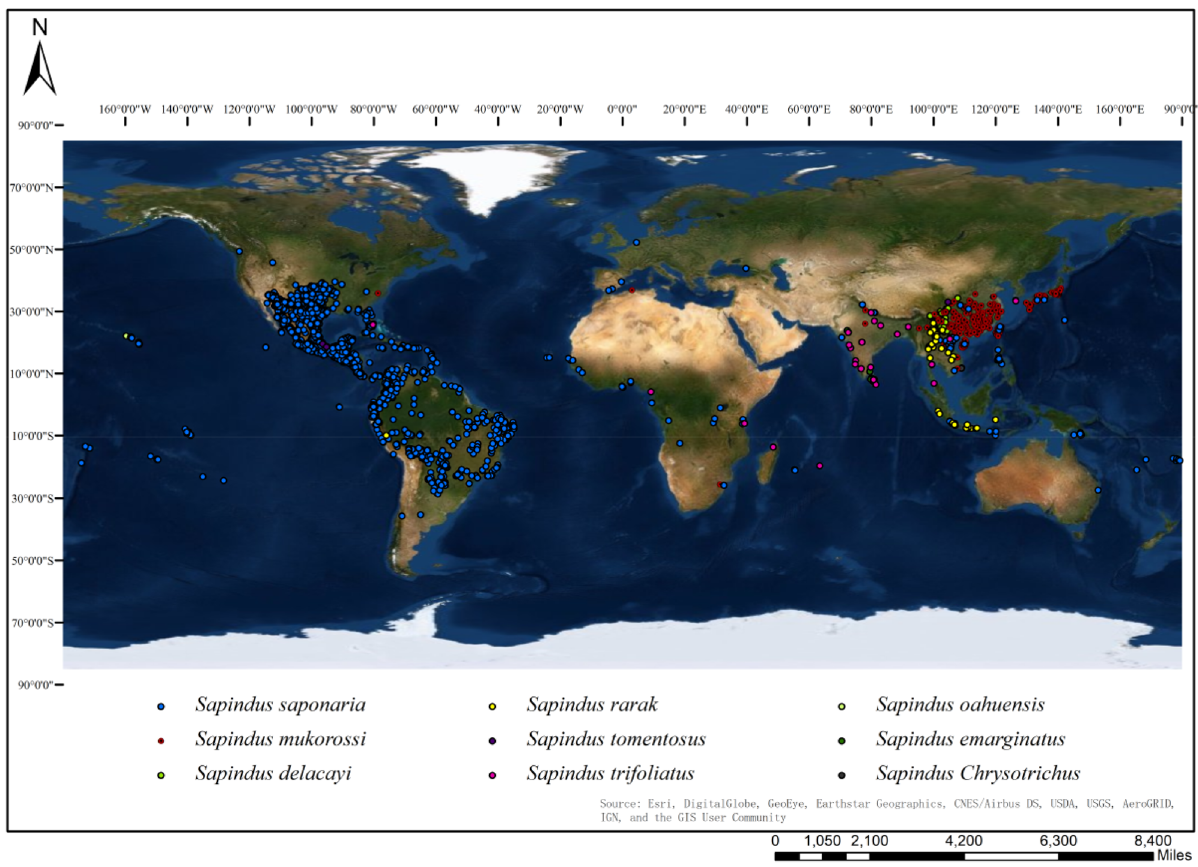
Figure 5. Global distribution of occurrence records for Sapindus . Created in ESRI ArcMap 10.5 (https:// suppo rt. esri. com/ en/ Produ cts/ Deskt op/ arcgis- deskt op/